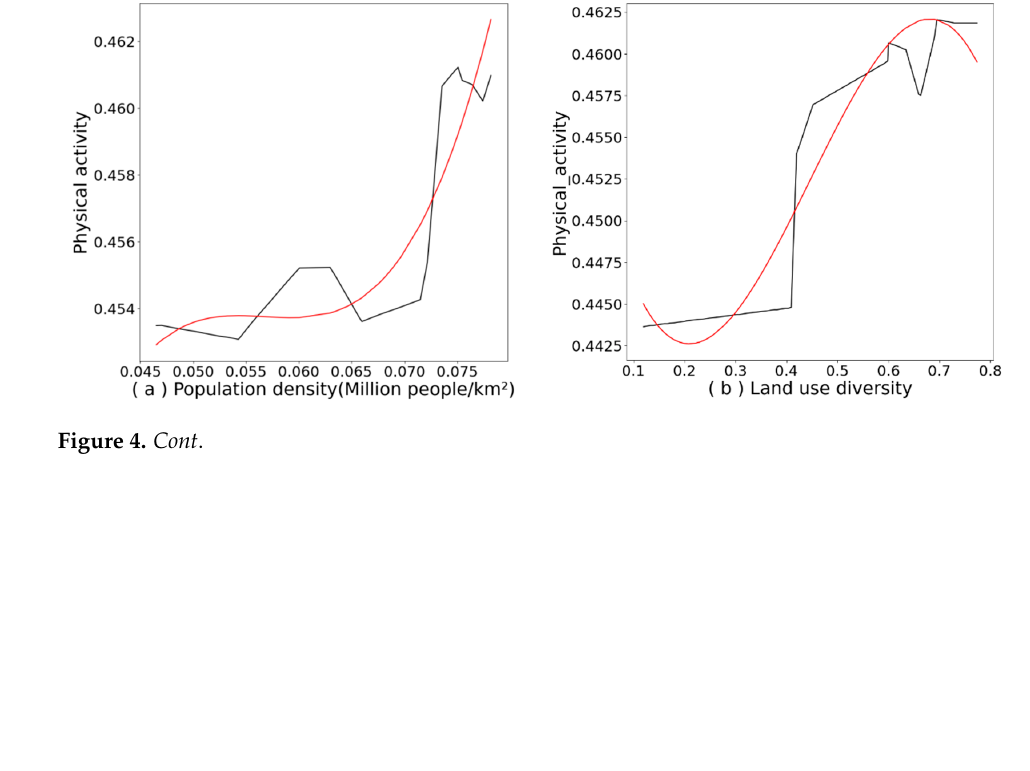
Figure 3. Predictor variables’ relative relevance.